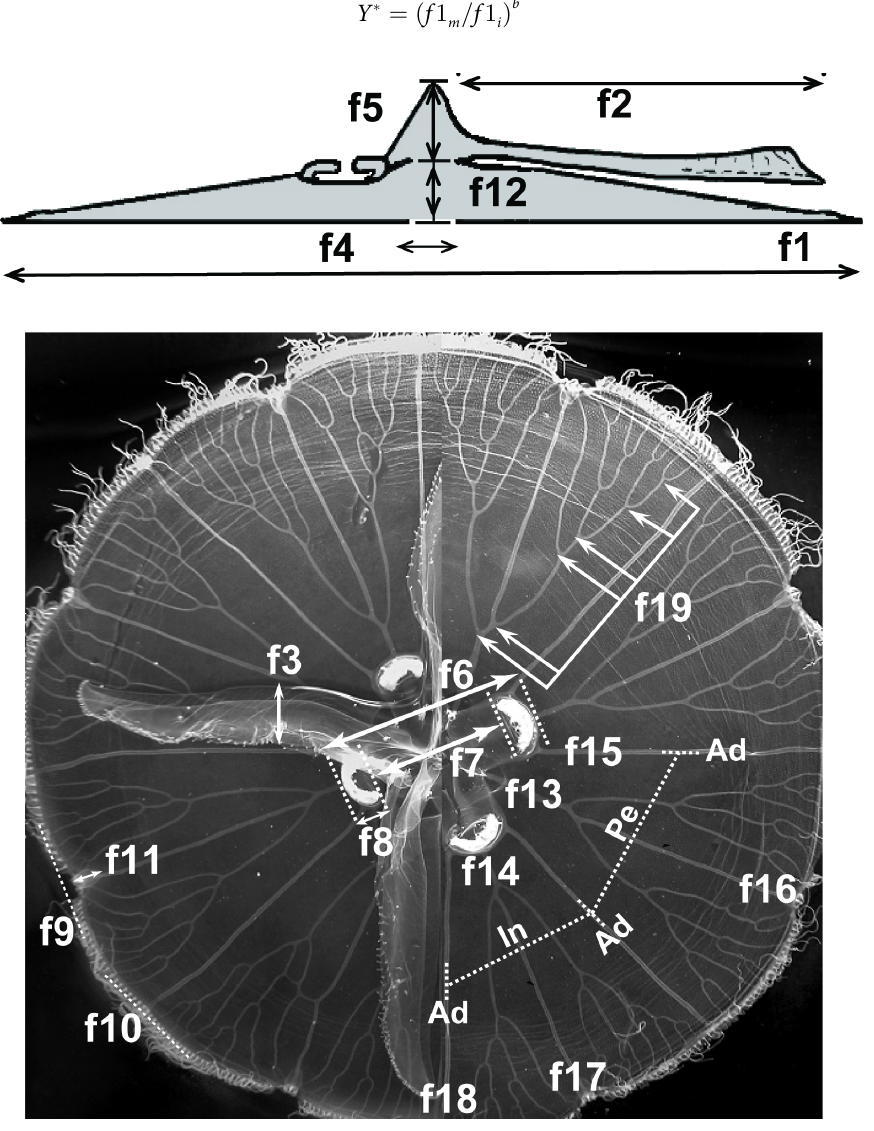
Fig 3. Continuous and meristic morphological features recorded in this study. Cross-sectional (A) and sub-umbrellar (B) views of an Aurelia medusa. Categorical features are not shown. Refer to S2 Table for feature